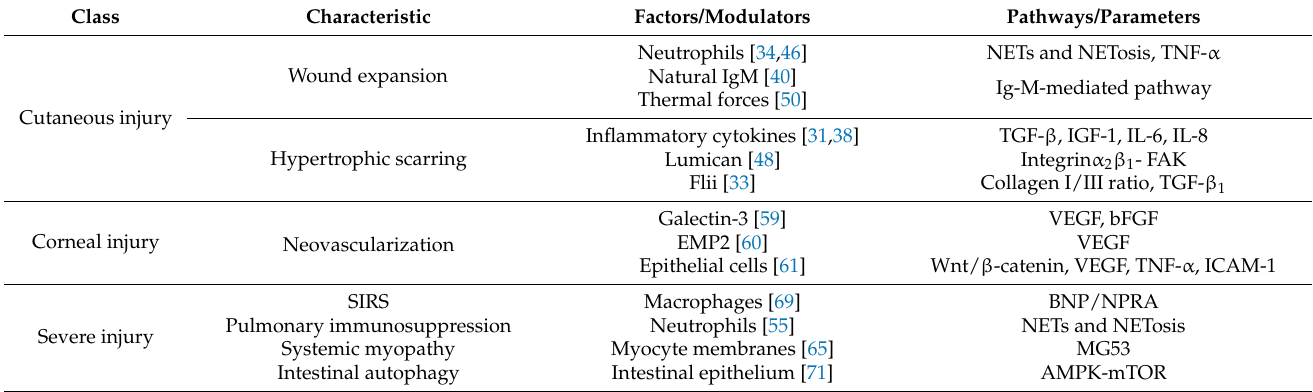
Table 2. Signaling pathways evaluated in response to